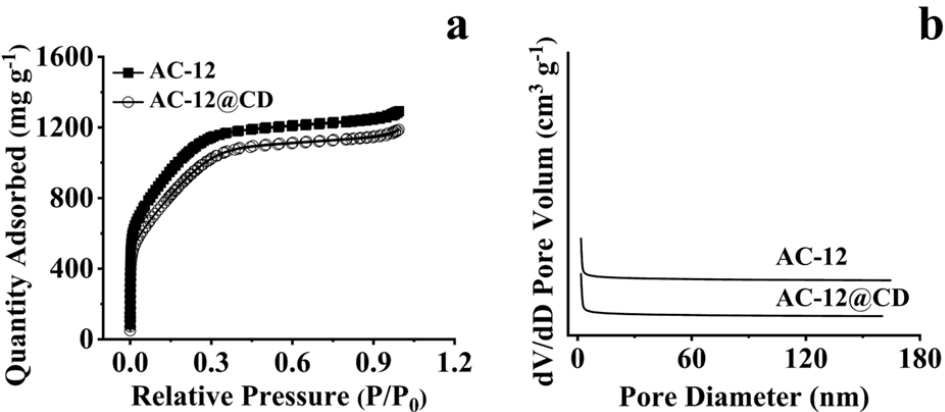
Figure 2. N 2 adsorption analysis diagram of AC-12 and AC-12@CD. ( a ) Adsorption isotherm, ( b ) pore size distribution diagram.